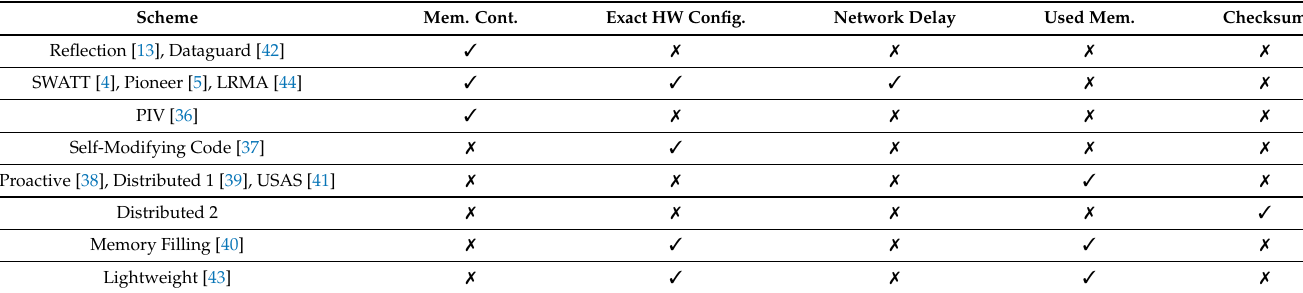
Table 4. Overview of software-based RA schemes w.r.t. required verifier knowledge. Scheme Mem. Cont. Exact HW Config. Network Delay Used Mem.